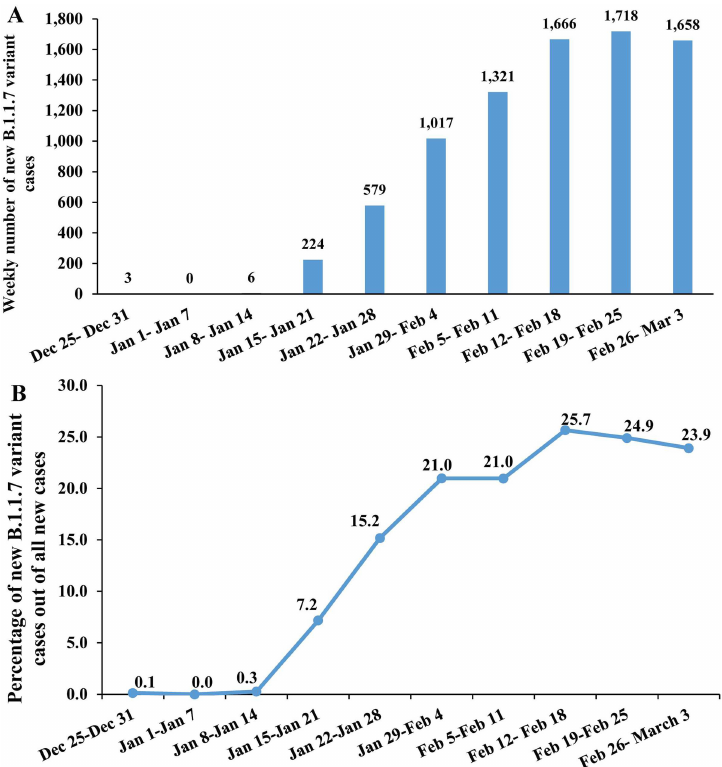
Fig 1. SARS-CoV-2 B.1.1.7 variant expansion in Qatar. (A) Time series of the number of new B.1.1.7 cases. (B) Percentage of new B.1.1.7 variant cases among all PCR-confirmed cases.